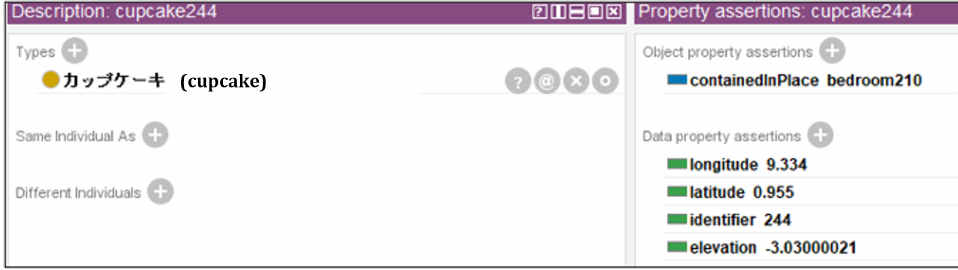
Figure 12. Examples of instances in home